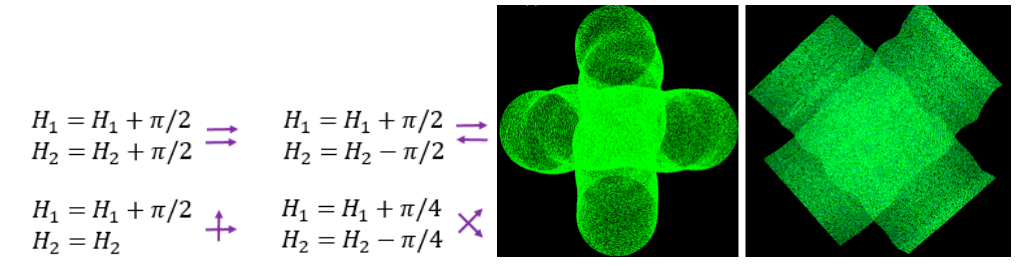
Figure 4. Preparation of orientation of simulated flight lines.